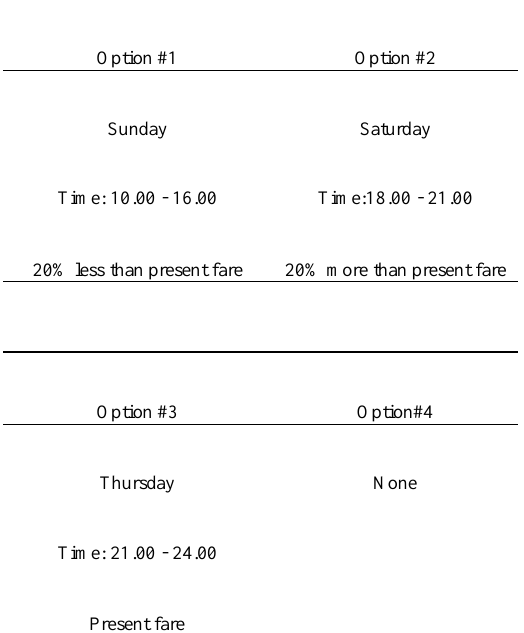
Table 2. An example of a conjoint